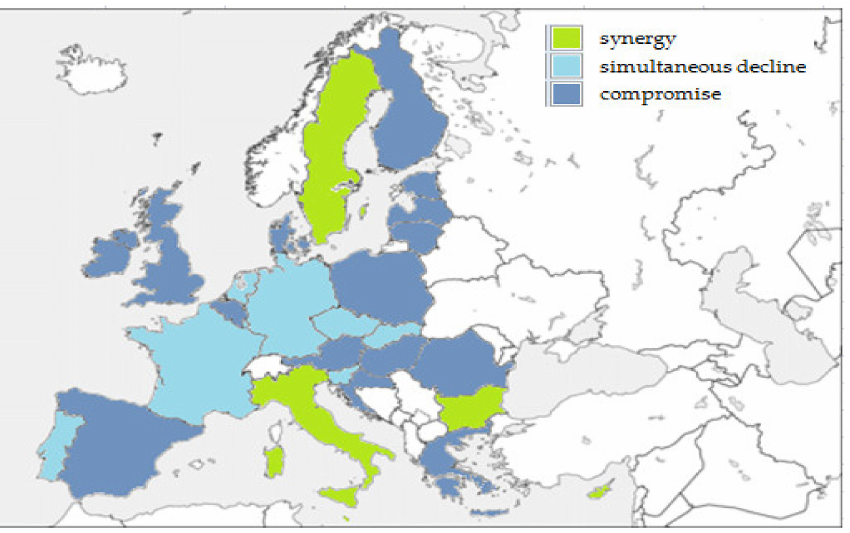
Figure 2. Map of synergies and compromises in the implementation of the SDG13 and SDG3 sustainable development goals in EU